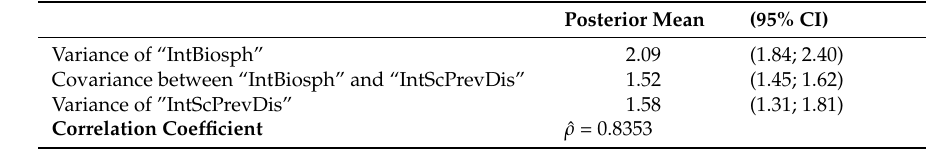
Table A5. MCMC estimates of the residual variance-covariance matrix for the BOP model of students Interests.